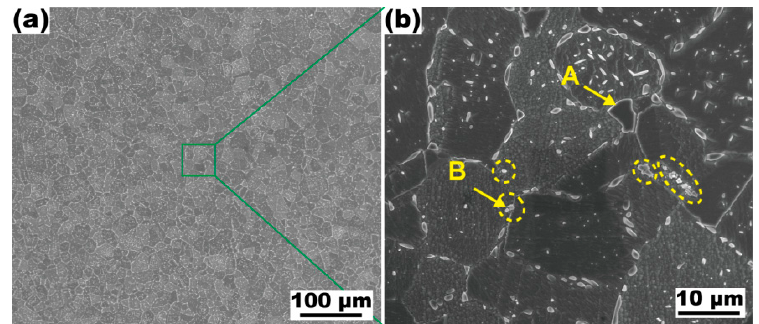
Figure 7. SEM micrographs of the Cu-15Ni-8Sn-0.3Si-0.1Ti alloy after annealing at 1093 K for 2 h. Intergranular micron particles are highlighted by the yellow dotted line. Table 4. EDS results of corresponding positions in Figure 7 (wt.%).